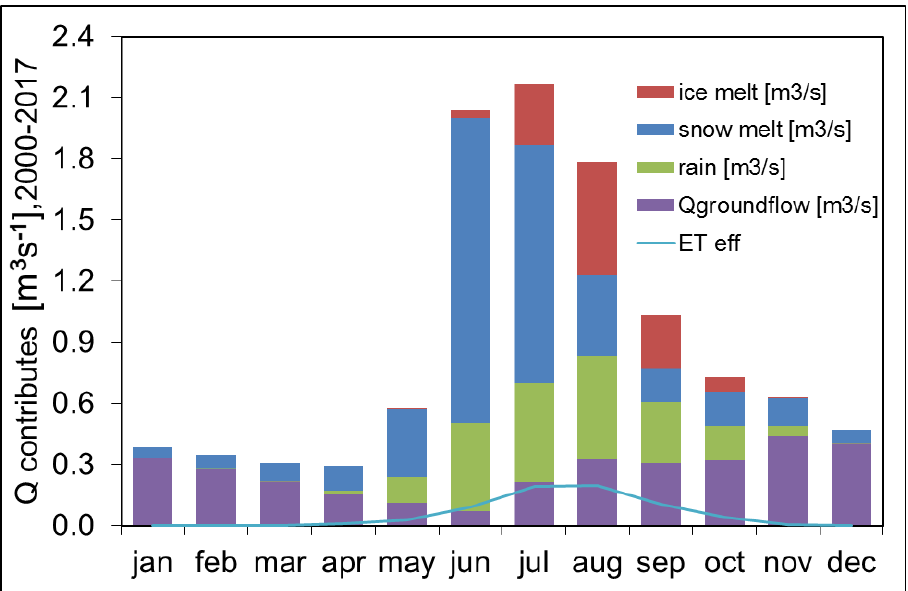
Figure 4. Sabbione catchment. Estimated mean monthly flows (2000–2017). Estimated flow contributions (ice melt, snow melt, rainfall, ground flow) reported.